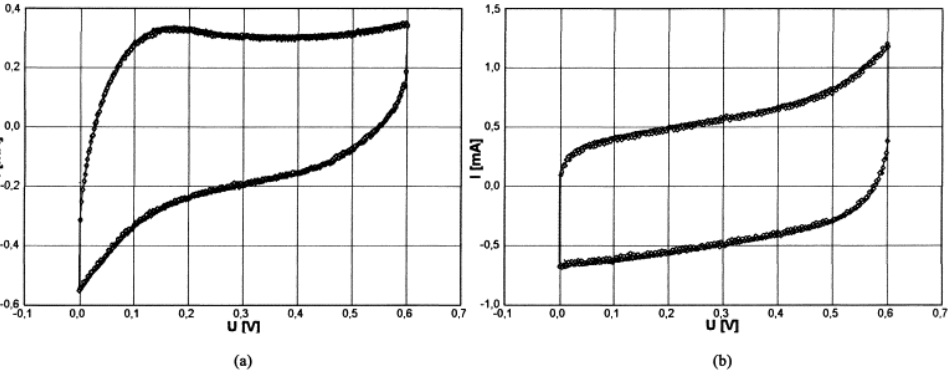
Figure 13. Potentiostats of MWCNT electrodes without ( a ) and with ( b ) polypyrrole (Ppy) in 1 M H 2 SO 4 electrolyte [109]. Reprinted with permission from Elsevier.